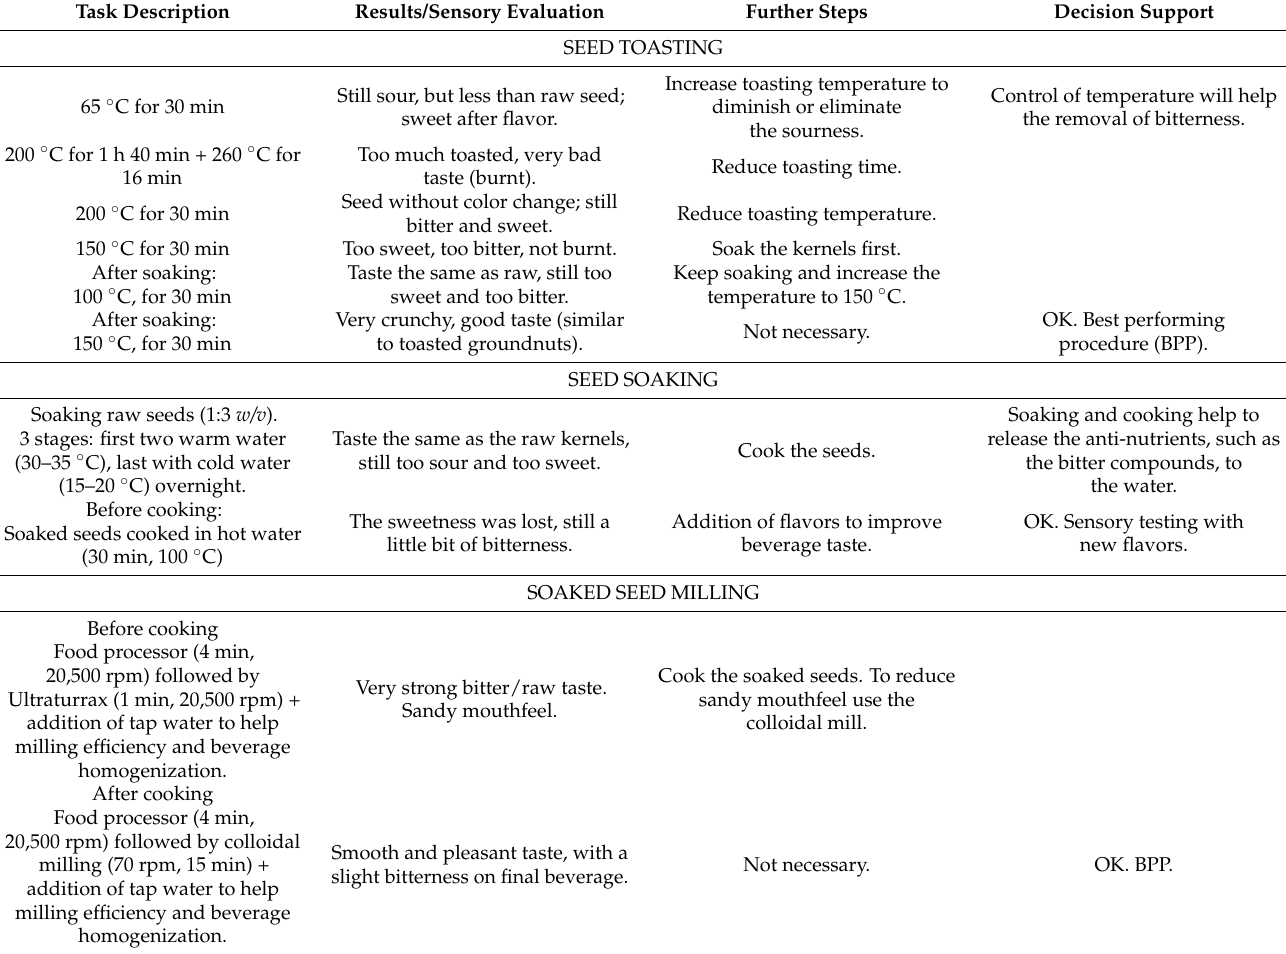
Table 1. Progress of processing stages for M. oleifera seed-based foods (toasted seed, beverage and yoghurt-like) to achieve final